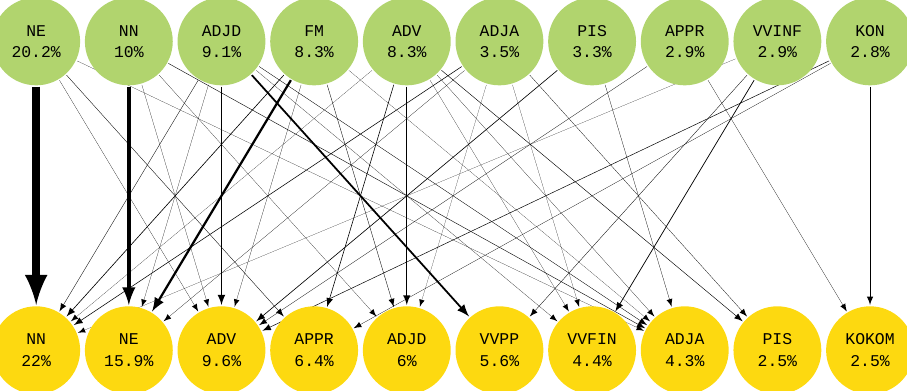
Figure 4: Depiction of the distribution and extent of erroneous POS tagging, comparing gold-standard tags (top) with test-results (bottom), using STTS for LemmaTag on Tiger standard, and for test results, while arrows indicate at least ten mis- matches. Percentages represent the ratio of all incoming or outgoing arrows with respect to the overall total. Apparently, most errors are caused by named entities recognized as nouns and vice versa.